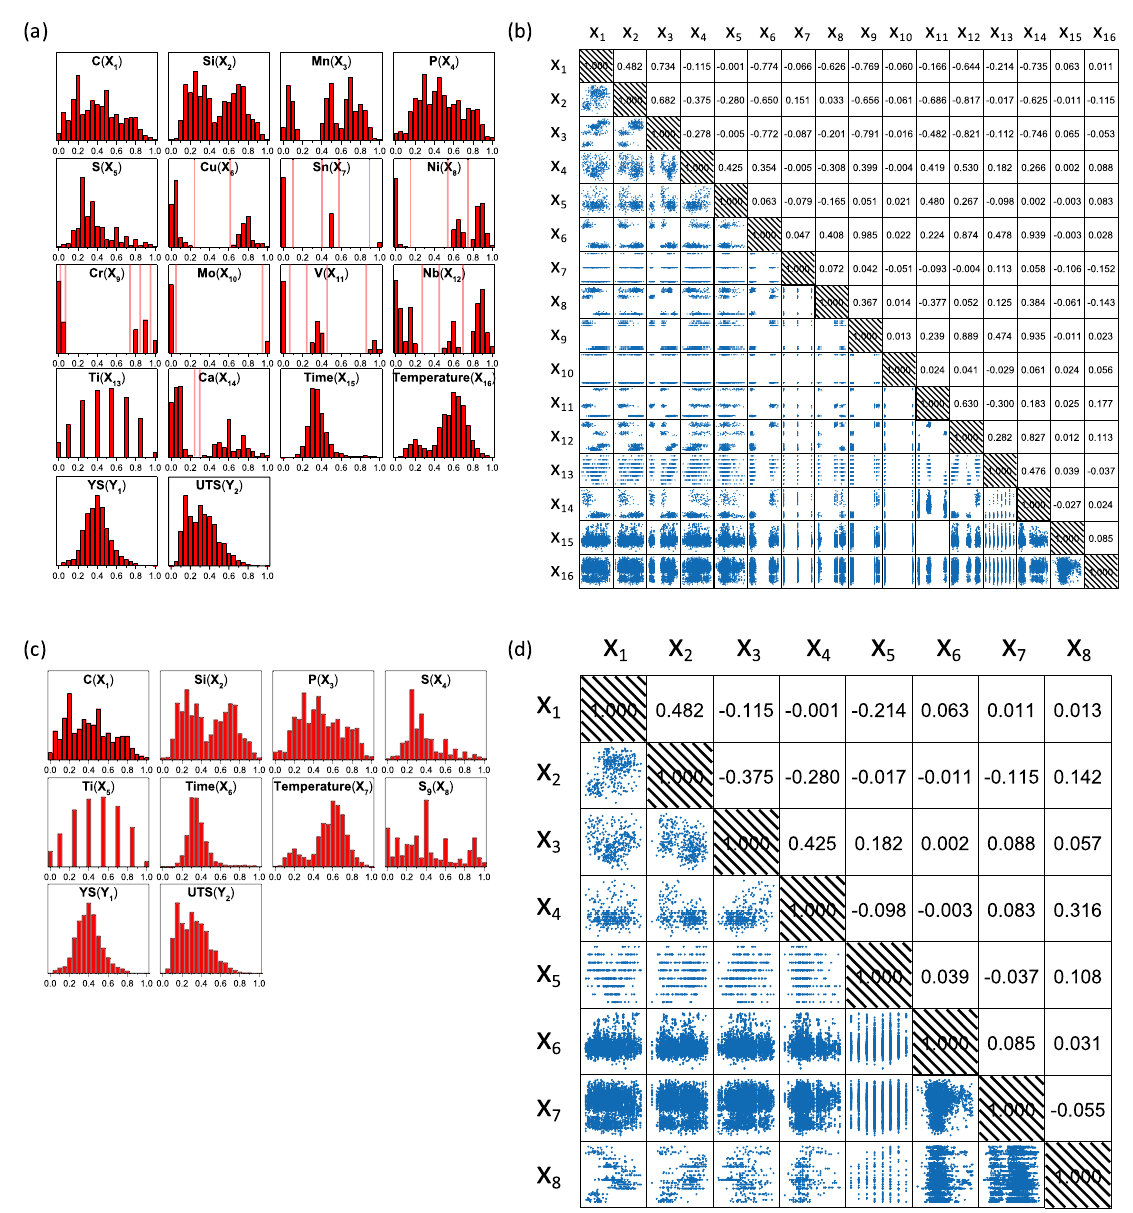
Figure 2. ( a ) 1-D data distribution for each of the 16-input and 2-output features, ( b ) the Pearson correlation coefficient matrix for 16-input features; the upper off-diagonal components are the Pearson correlation coefficients and the lower off-diagonal components are 2-D data distribution plots. ( c ) 1-D data distribution for each of the 8-input and 2-output features, ( d ) the Pearson correlation coefficient matrix for 8-input